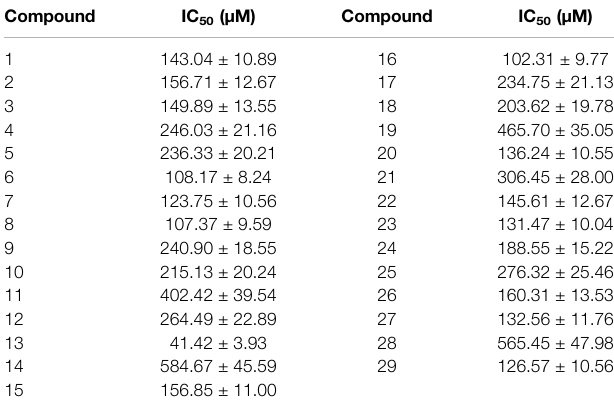
μ M). TABLE 4 | Inhibitory effects of compounds 1 – 29 on NO in LPS-induced BV-2 50 , Cells ( n = 3, x ± s